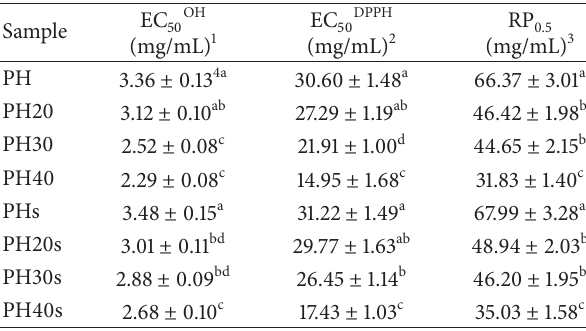
Table 2: Antioxidant activities of honey samples.